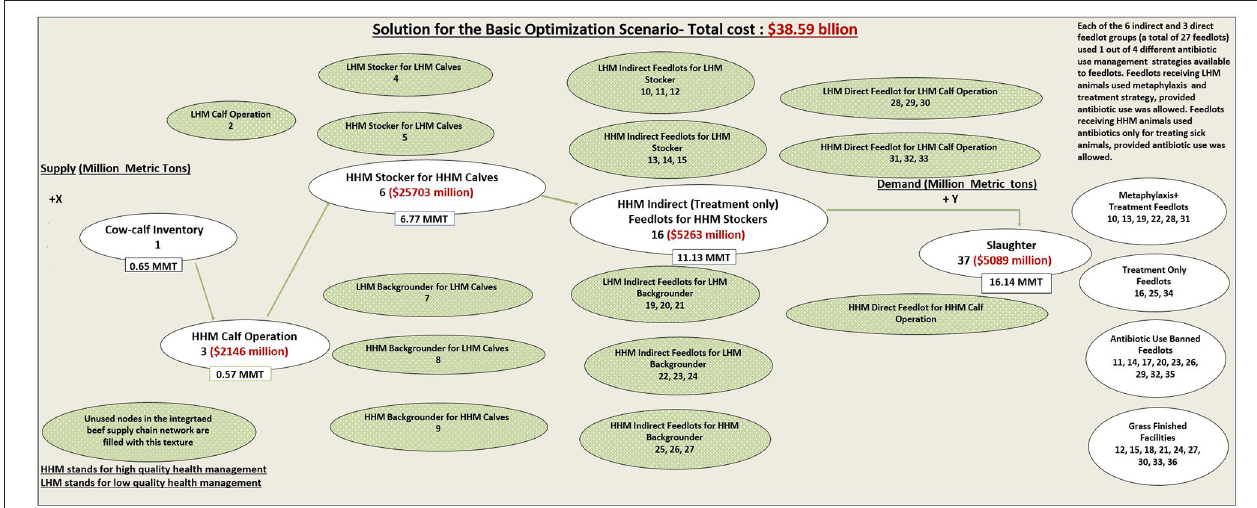
FIGURE 3 | The schematic representation of the optimal solution for the basic optimization scenario with the 5 used nodes through which the least cost beef supply happens is shown. in weight to a per-head weight of 590 kg to meet the final demand of 16.14 MMT and are available at node 37 for slaughter. The cost incurred by node 16 for weight gain from 11.13 MMT to